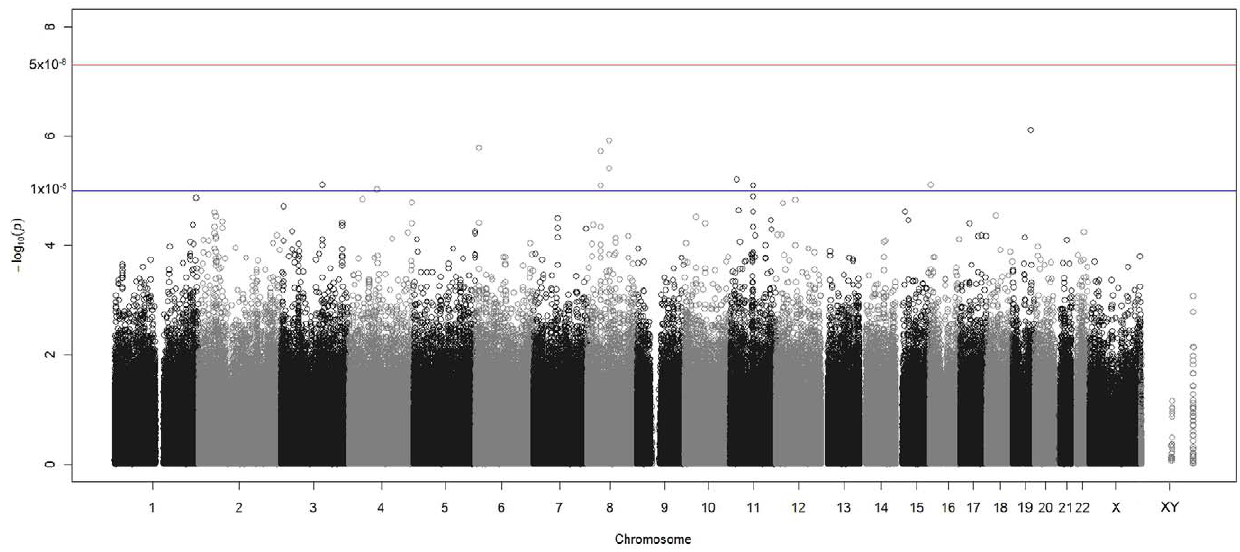
Figure 1. Manhattan plot for analysis of HIV-1 acquisition. -log 10 (p) is plotted for all SNPs against physical location of each SNP in the genome (listed by chromosome number 1 through 22, and X and XY). The threshold for genome-wide significance (P=5.1 6 10 2 8 ) is indicated.